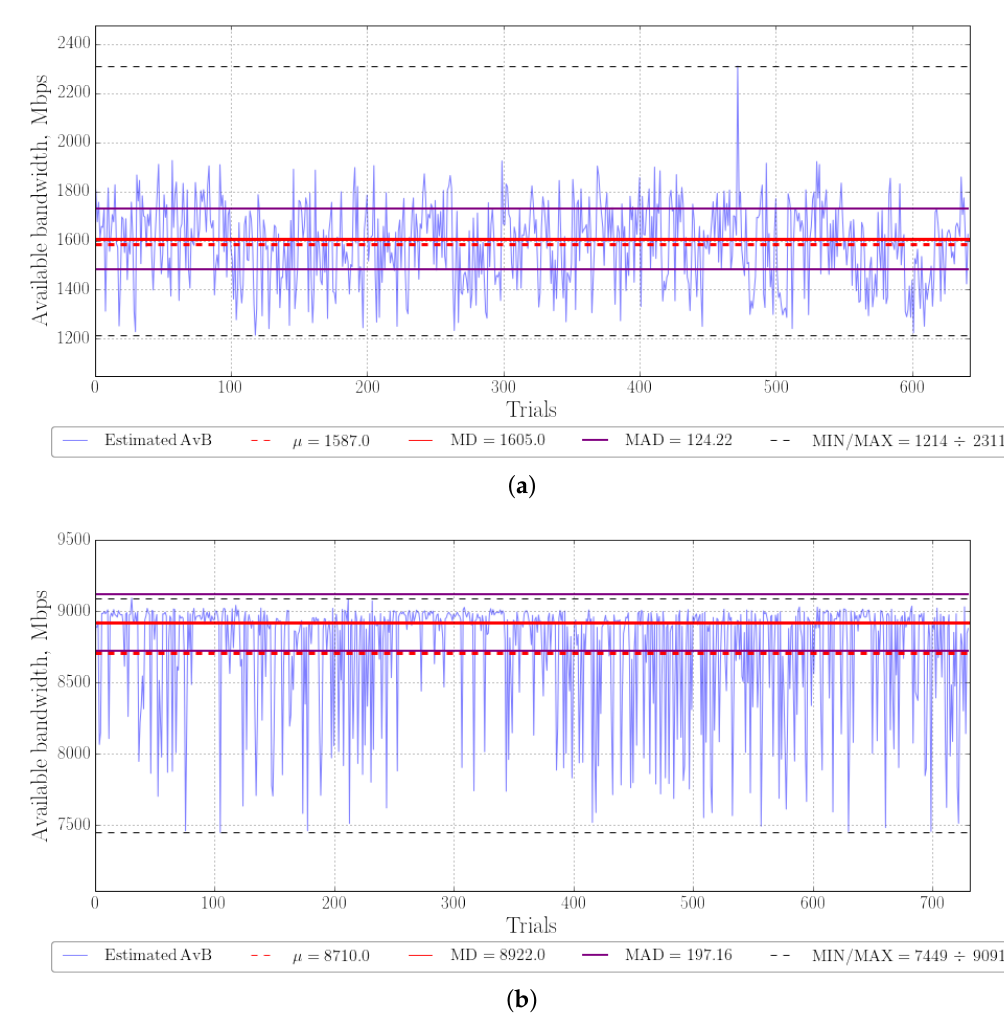
Figure 19. Kite2 AvB estimation of 10 Gbps Network in Qemu environment with 1 Gbps cross traffic: ( a ) standard system operations; and ( b ) with